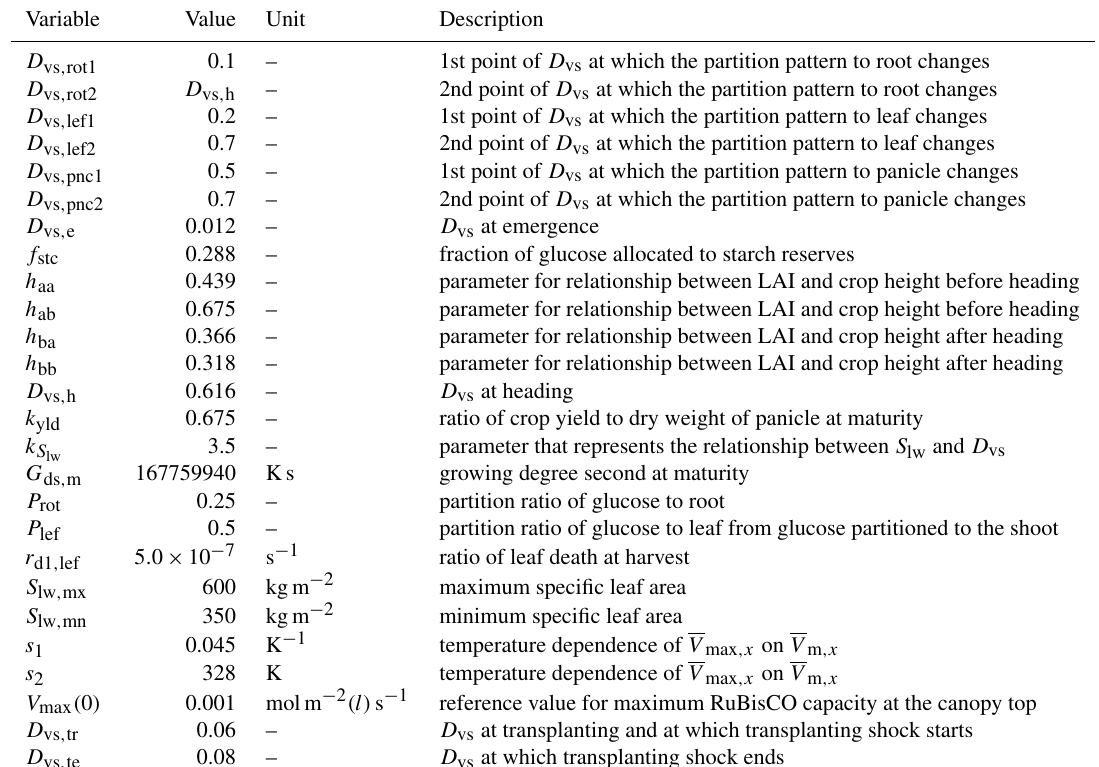
Table 2. Parameters parameterized.